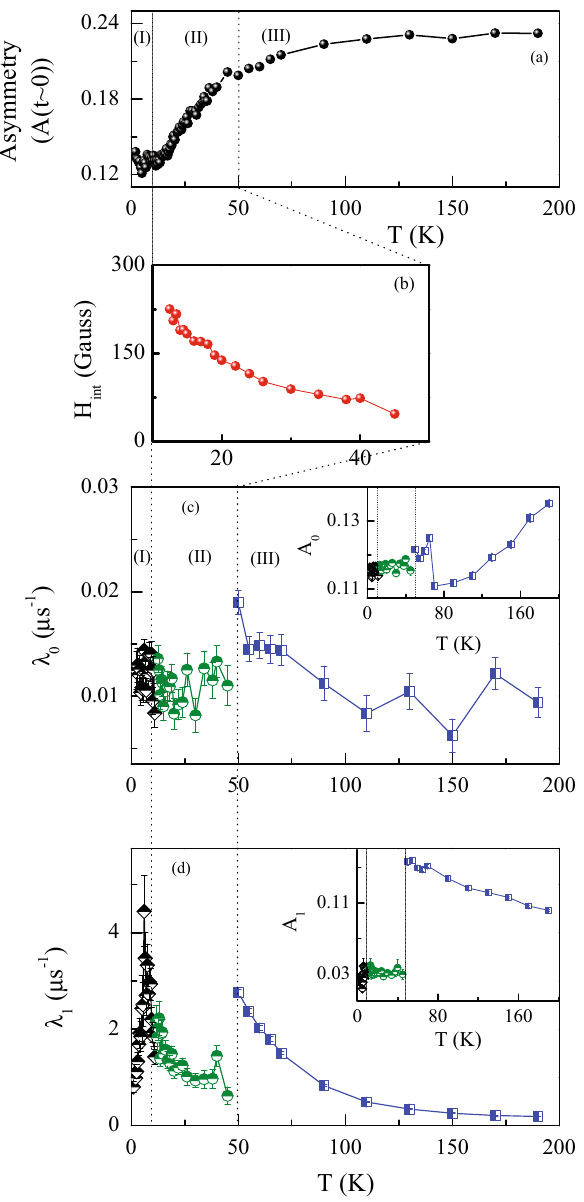
Figure 13. (a) Variation of total asymmetry at t ∼ 0 µ s from the raw spectra. (b) Variation of internal field ( H int ) with temperature. (c) Temperature variation of (cid:31) 0 and corresponding asymmetry A 0 is shown as inset. Region (I), (II) and (III) are described using Eq. (7) with σ = 0 , Eqs. (9) and (7) respectively. (d) Temperature dependence of (cid:31) 1 and the inset presents the variation of A 1